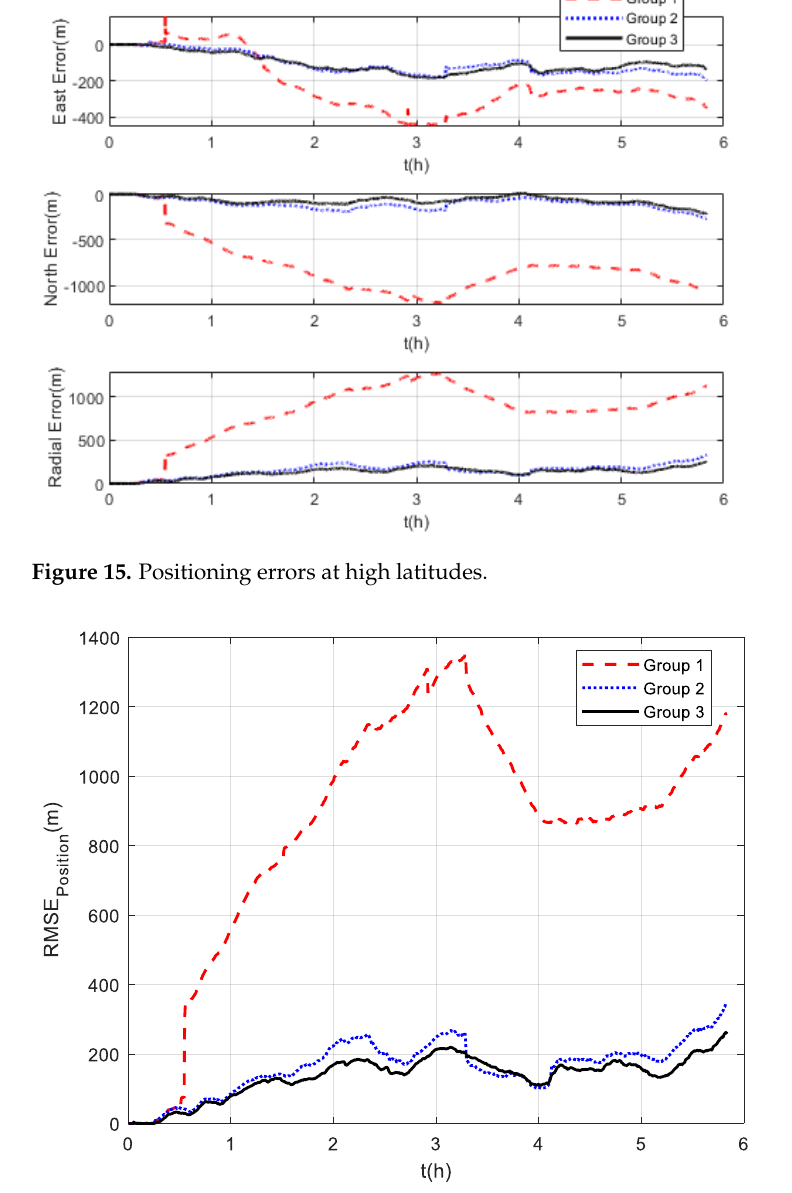
Figure 16. RSME of position at high latitudes.